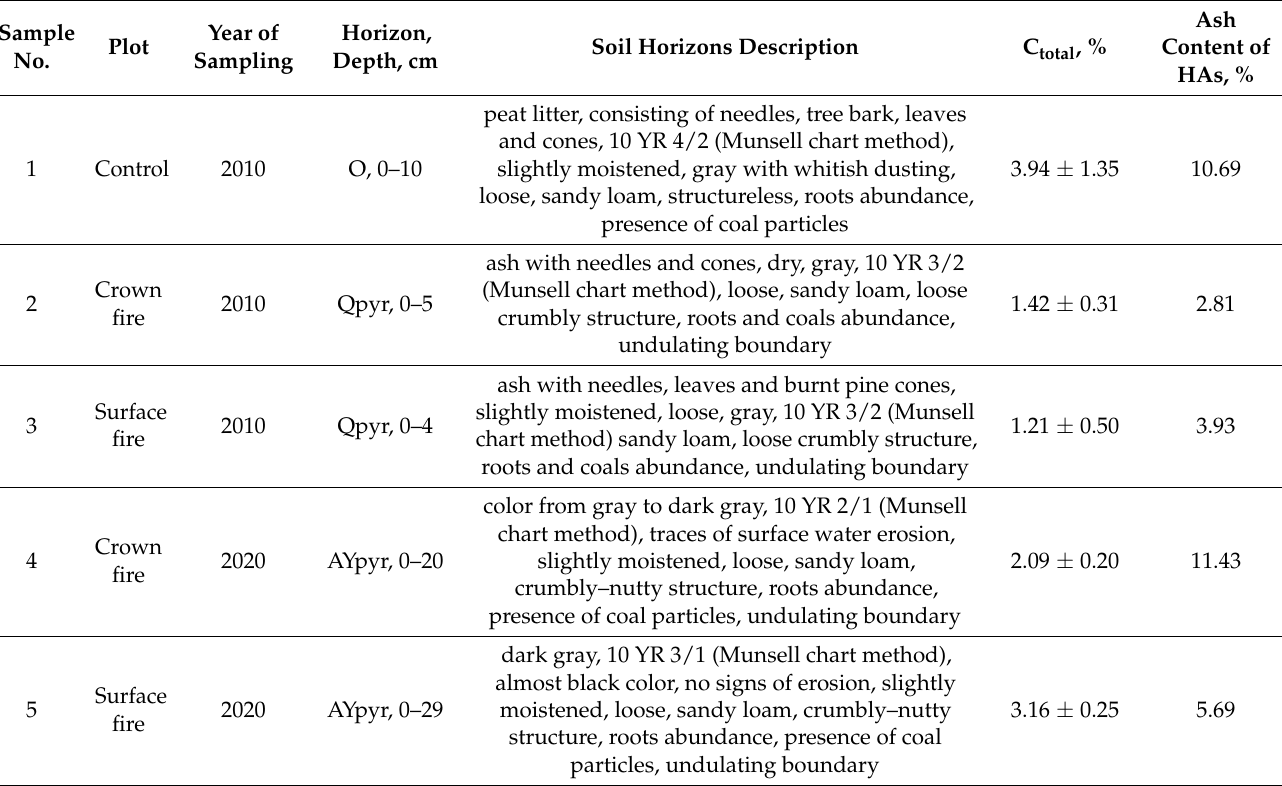
Table 1. The description of soils studied and HAs extracted.